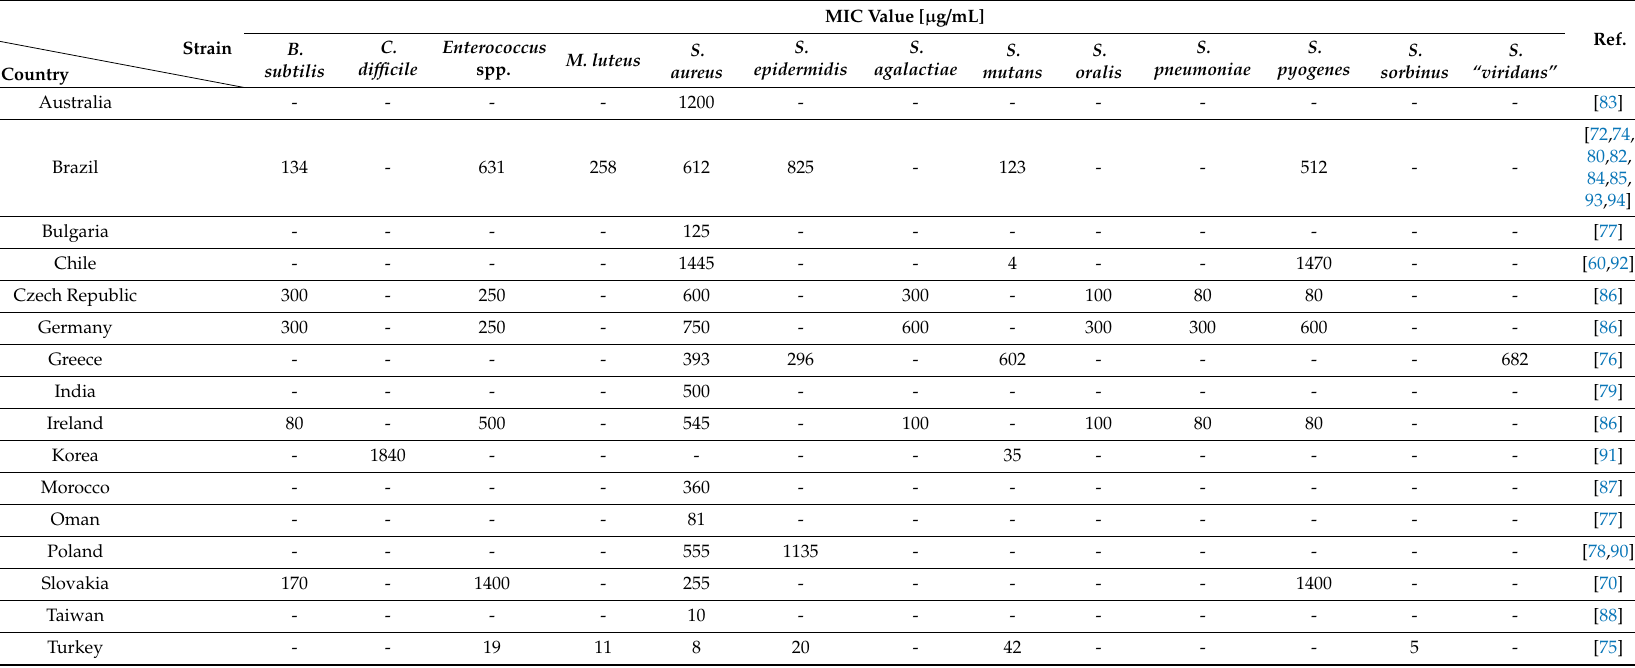
Table 3. The MIC values for EEP from di ff erent geographical origin against Gram-positive bacteria (“-”—no data). MIC Value [ µ g / mL]